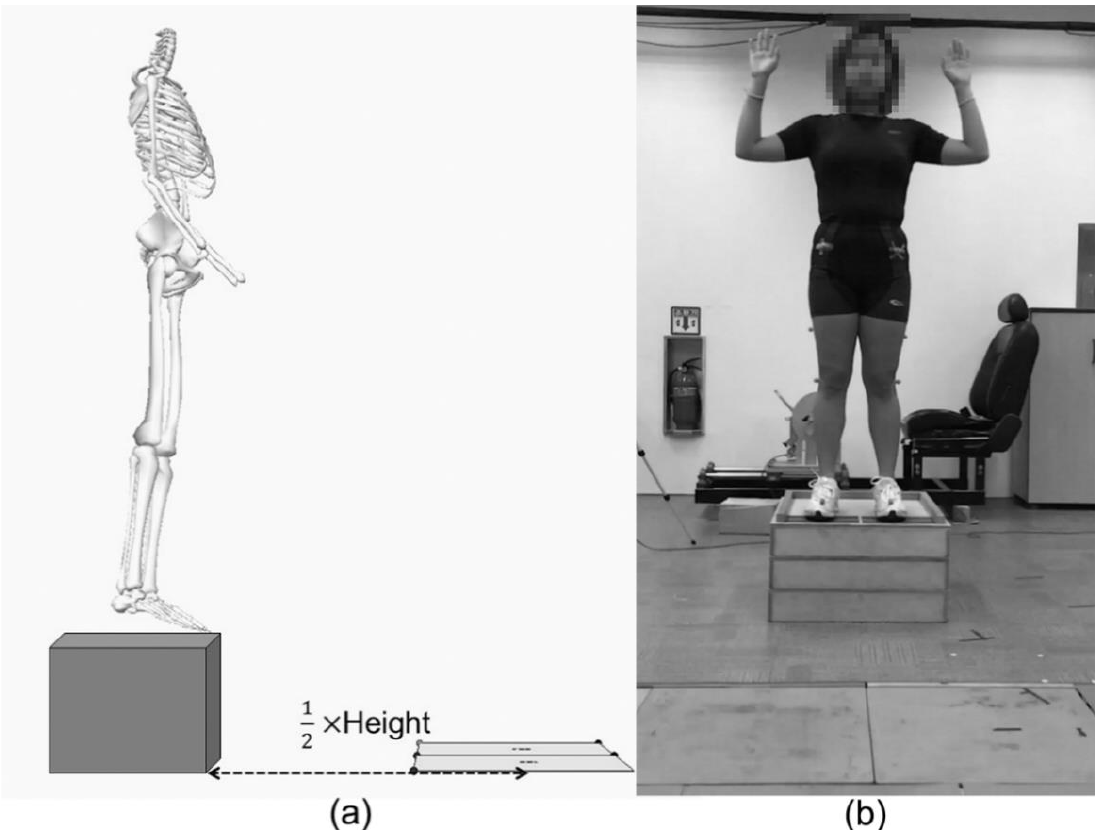
Figure 1. ( a ) The box was located to half of each participant’s height from the centre of force platforms. ( b ) Participant’s posture for drop vertical jump. Arms were controlled with approximately 90 degrees abduction and elbow flexion.